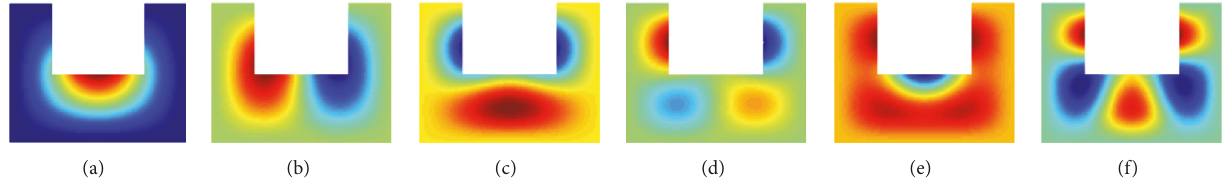
Figure 5: The first six mode shapes of the square plate with a corner cutout. (a) The first mode; (b) the second mode; (c) the third mode; (d) the fourth mode; (e) the fifth mode; (f) the sixth mode.